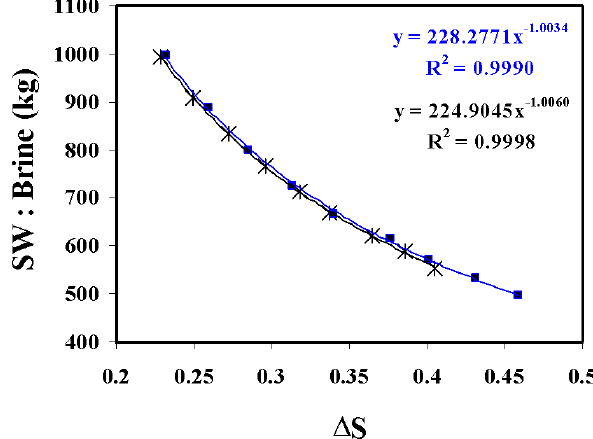
Fig. 3. Salt calibration curve. Exponential fits for two calibration datasets: calibration 1 (blue curve) is measured by increasing salin- ity from natural Baltic seawater S = 17; calibration 2 (black curve) is done after salinity was already increased from 17 to 17.1 by NaCl addition. Power formulas can be used to calculate mesocosm vol- ume by multiplying y with the added amount of